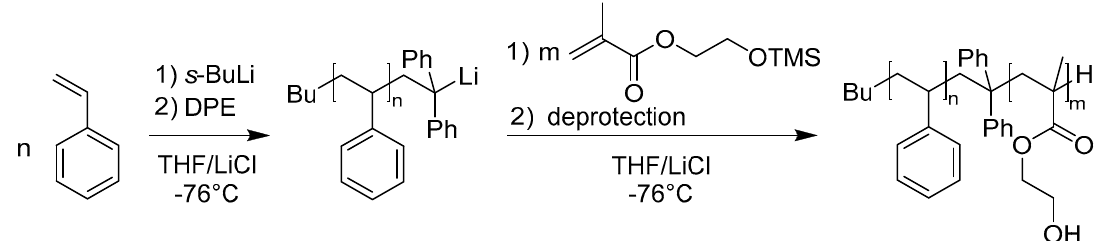
Figure 1. Sequential anionic polymerization of styrene and trimethylsilyl-protected 2-hydroxyethyl methacrylate leading to polystyrene- block -poly(2-hydroxyethylmethacrylate) (PS- b -PHEMA) block copolymers.